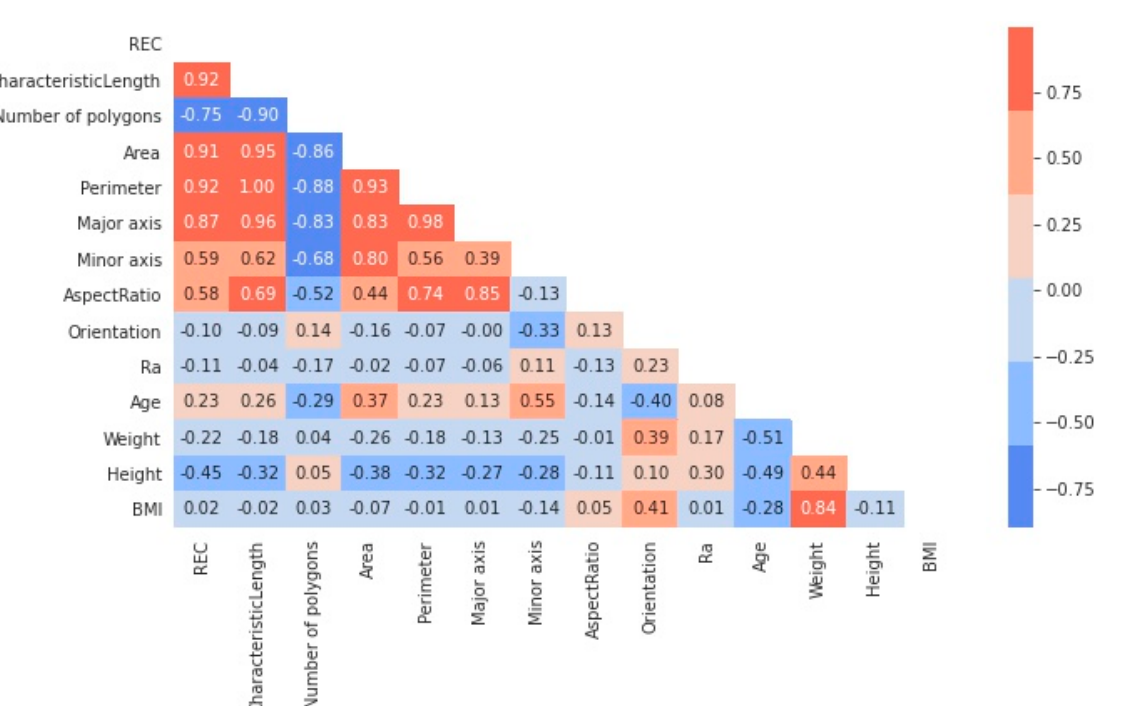
6 of 12 Table 1. Results of skin replica surface analysis: average roughness and watershed segmentation.